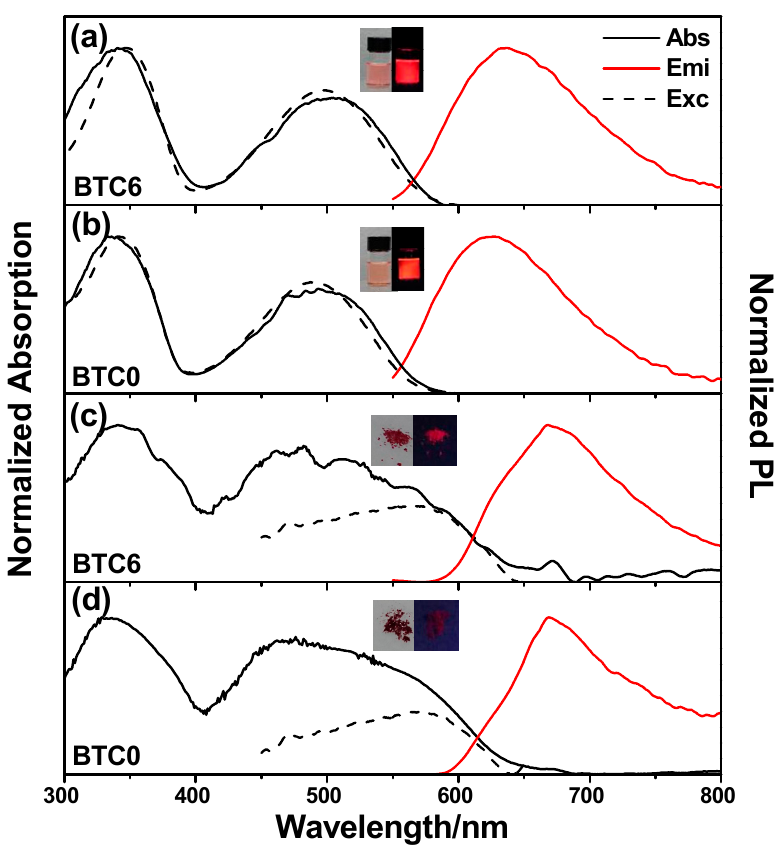
Figure 2. The absorption, emission, and excitation spectra for BTC6 in a chloroform solution (1.0 × 10 − 5 M) ( a ) and in the solid state ( c ). The absorption, emission, and excitation spectra for BTC0 in a chloroform solution (1.0 × 10 − 5 M) ( b ) and in the solid state ( d ). Table 1. The photophysical data of BTC0 and BTC6 in solution and powder at 298 K.